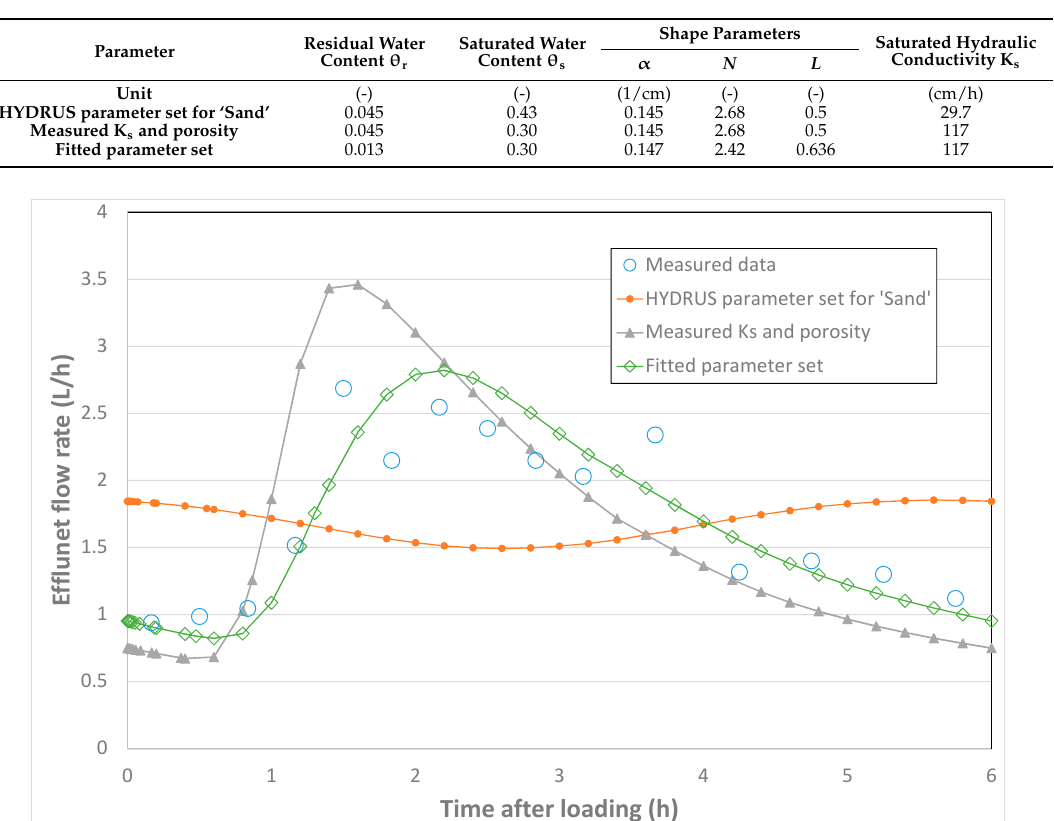
Table 3. Soil hydraulic parameters of the van Genuchten–Mualem model [35] for the 0.06–4 mm main layer.